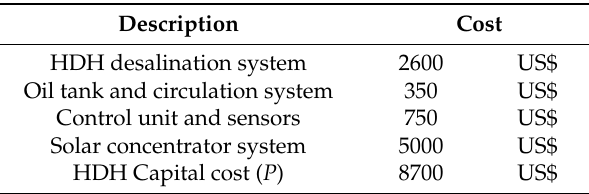
Table 3. Capital cost of the HDH